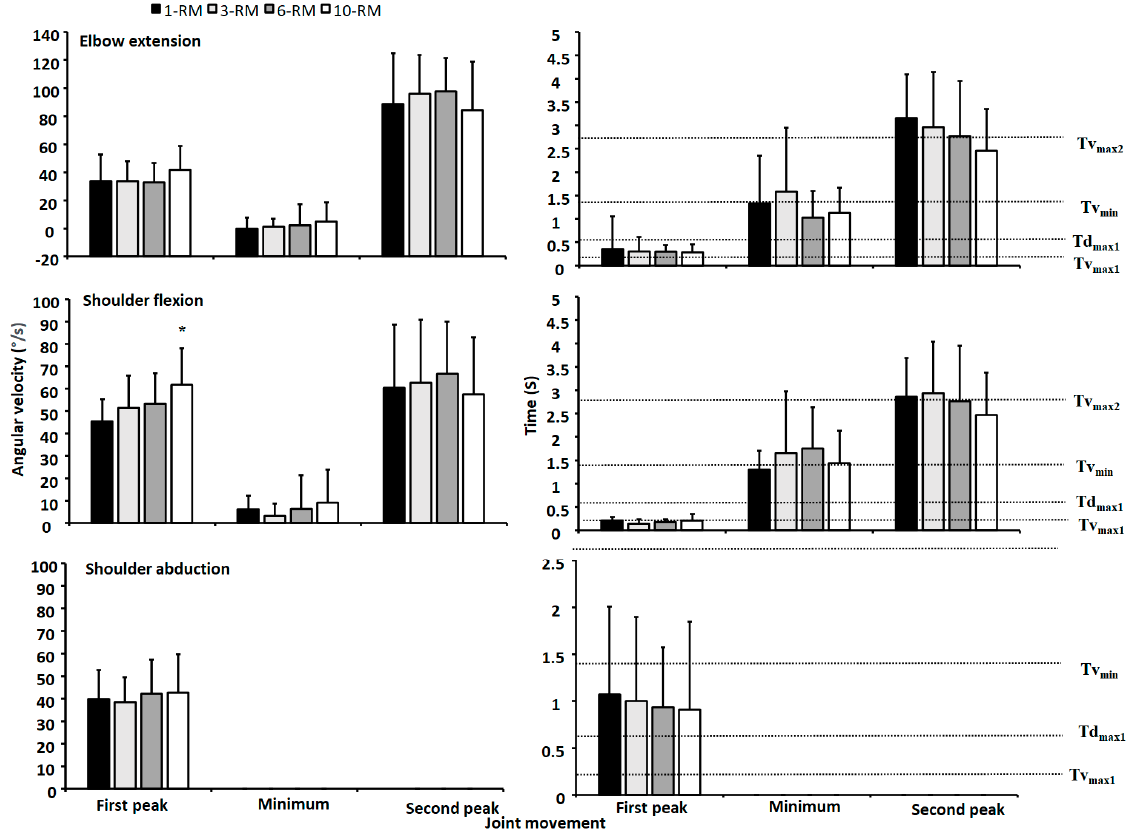
Figure 3. Peak and minimal mean ± SD joint movements for elbow extension, shoulder flexion and shoulder abduction velocity with their timings for the 1-RM, 3-RM, 6-RM, and 10-RM in the bench press exercise. Also shown is the mean timing of the events v max1 , d max1 , v min and v max2 for all bench press conditions relative to the timing of the joint movements. * Indicates a significant difference in barbell velocity between the 10-RM compared with the 1-RM and 3-RM at this event in the bench press exercise ( p < 0.05).